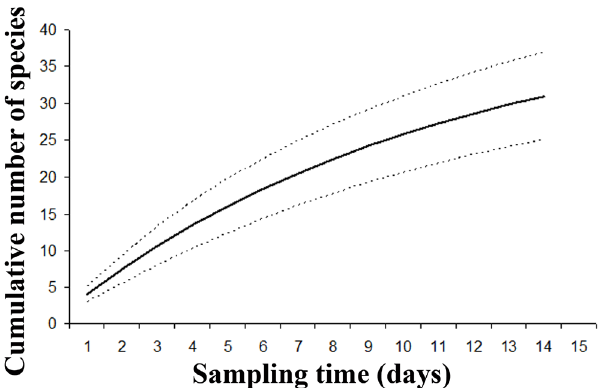
Figure 3. Sample-based species rarefaction curves for reptile records in the Reserva Extrativista do Rio Gregório. Line represents the rarefied number of species per day, and dots are the correspondent standard